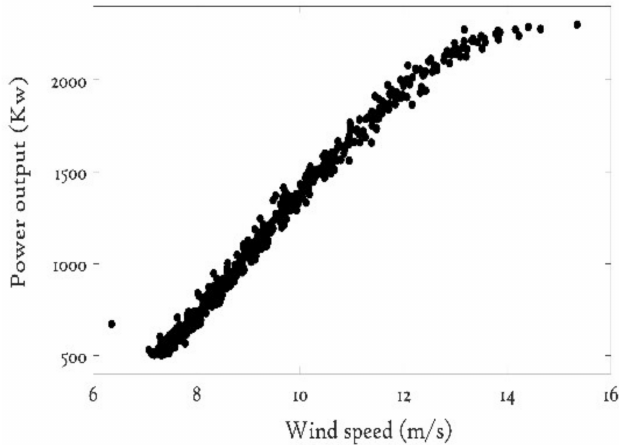
Figure 5. Filtered power curve.